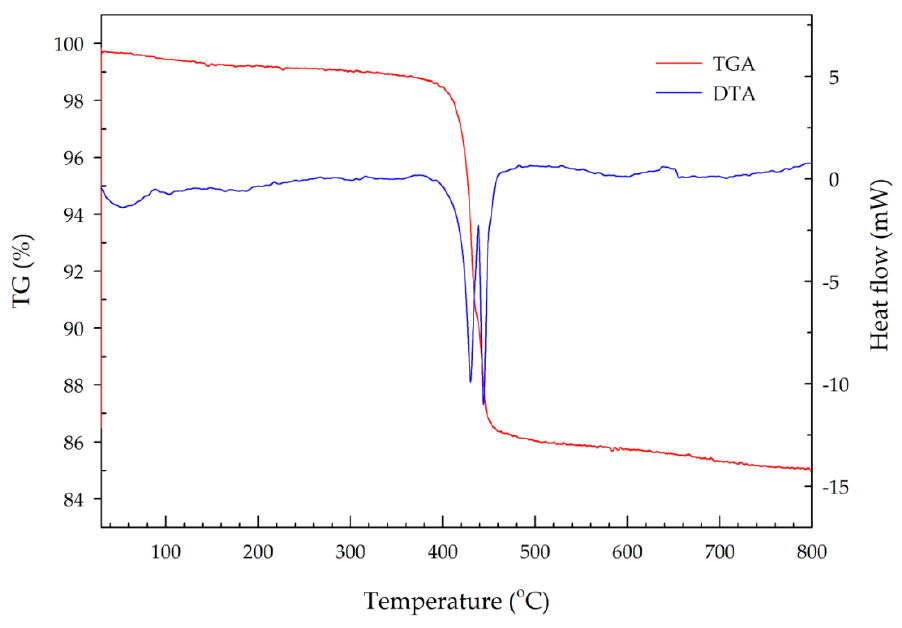
Figure 7. TGA-DTA plot of synthesized manganese violet.